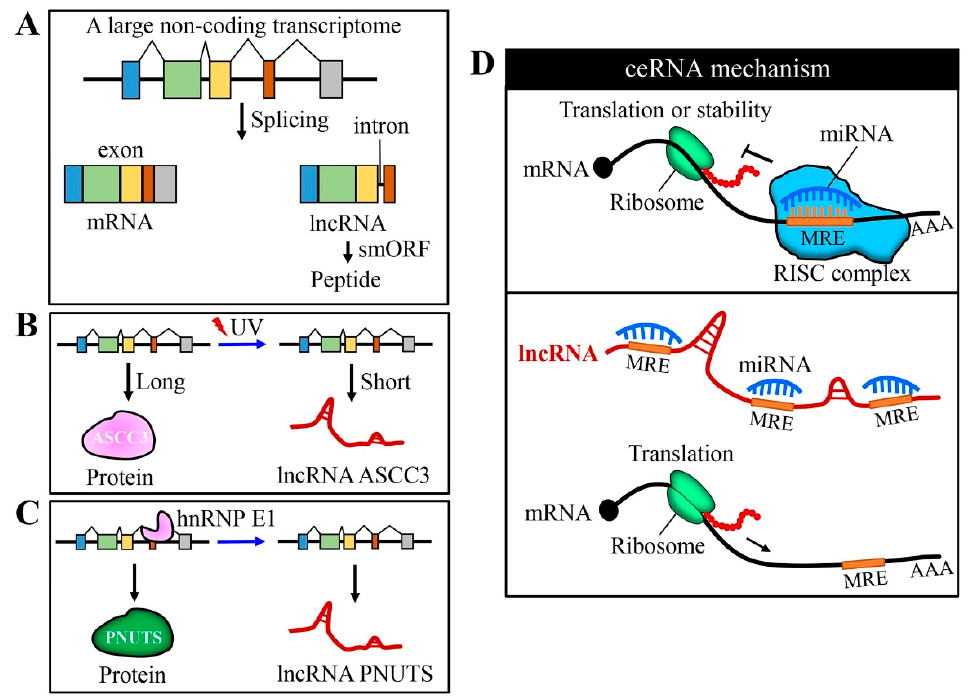
Figure 1. Generation of long non-coding RNAs (lncRNAs) and their function as competing endogenous RNA (ceRNA). ( A ) Alternative splicing gives rise to the complex mammalian genome; lncRNA variants may arise from the skipping of the first or last exon, resulting in the loss of start or stop codons. A part of lncRNAs harbors small open reading frames (smORF) and can encode short peptides with a function. ( B ) Protein and lncRNA can sometimes be encoded by the same gene. Exposure to UV light leads to a slowdown of transcript elongation and the ASCC3 gene expresses a shorter RNA isoform (lncRNA ASCC3), instead of protein. ( C ) The binding of heterogeneous nuclear ribonucleoprotein E1 (hnRNPE1) to a nucleic element within exon 12 of the serine/threonine-protein phosphatase 1 regulatory subunit 10 ( PNUTS ) gene that regulates its alternative splicing to generate the lncRNA PNUTS. ( D ) In general, miRNAs bind to the 3 ′ untranslated (UTR) region of target mRNAs and regulate their expression at a post-transcription level (inhibiting translation and/or decreasing the stability of mRNA). LncRNAs can act as sponges for miRNA through their binding sites and inhibit the function of miRNA on its target gene(s).